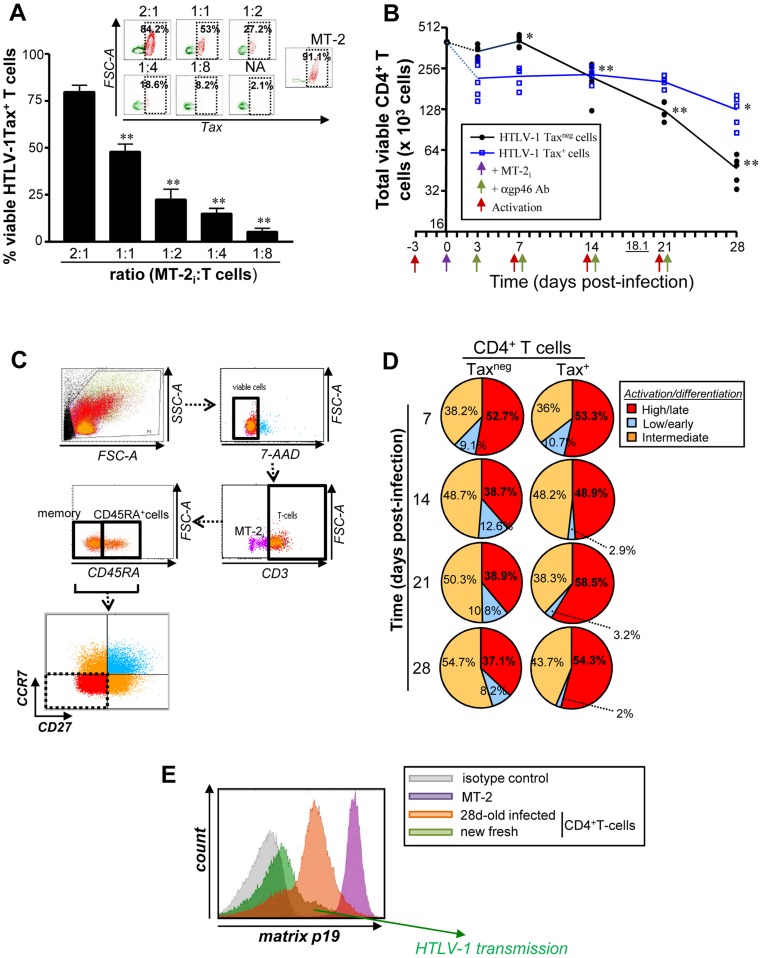
Productive HTLV-1 infection is associated persistence of infectious CD4+CD27negCCR7neg T cells.Briefly, activated CD4+ T cells were productively infected with MT-2i for 2–28 days to assess their persistence and stepwise differentiation following multiple rounds of TCR stimulation. (A) Tax expression on activated Annexin-Vneg CD4+ T cells in response to various concentrations of irradiated MT-2 after 48 h pi. We used a CD4/MT-2i ratio of 1∶1 for subsequent experiments. Representative contour plots of five independent experiments were shown above (n = 5). (B) Absolute numbers of total viable Taxneg (black) and Tax+ (blue) CD3+T cells were determined by trypan blue exclusion. Results are expressed in log2 scale. P values were determined based on the comparison with cells at 3 dpi. The underlined number represents the half-life of cultured Taxneg T cells. (C) Briefly, cells were collected at 7–28 days pi using long-term co-culture assay and then stained with 7-AAD and anti-CD3-PE, anti-CD45RA-ECD, anti-CD27-APC H7, anti-CCR7-PE Cy7 and anti-Tax-Alexa 647 Abs. Gating strategies to distinguish for three distinct T cell populations, based on their stepwise activation/differentiation status from low/early, intermediate to high/late (CCR7+CD27+ [blue], single CCR7+ or CD27+ [orange], CCR7negCD27negcells [red], respectively). (D) Distribution of activated/differentiated 7-AADnegCD3+ T cells subsets based on CCR7 and CD27 staining at 7-28 days pi. Pie charts are representative of raw data from five independent experiments. (E) Transmission of HTLV-1 to fresh uninfected PE-stained T cells with 28 day-old HTLV-1-infected CD3+ T cells from the same donor (n = 3). Briefly, at 28 day pi infected CD4+ T cells were isolated using a CD3 positive selection (StemCell Technology, >97.6% purity). These cells were then co-cultured (ratio 1∶1) for 5 days with activated autologous CD4+ T cells that were stained 1 h prior to co-culture with anti-CD3-PE Ab. After 5 days, HTLV-1 transmission was measured on new CD3-PE-stained targets using p19 intracellular staining. MT-2 cells were used as positive control.